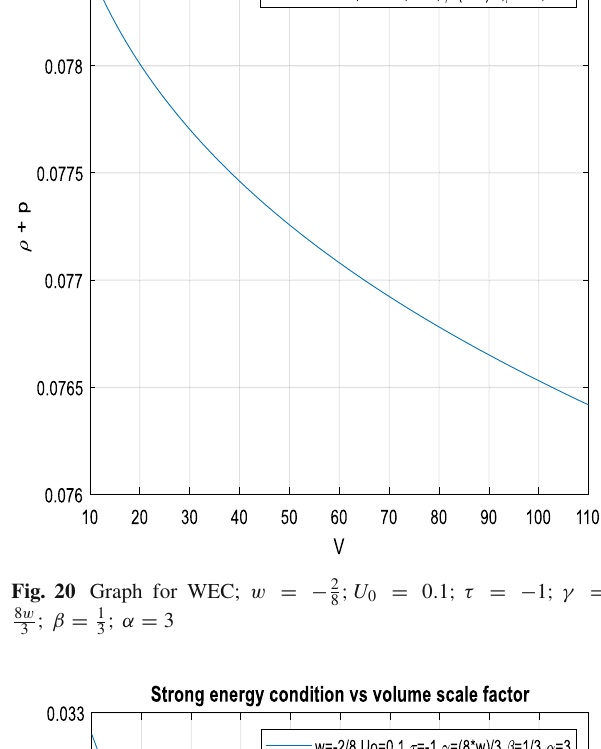
; U = 0 . 1 ; τ = − 1 ; γ = 0 8